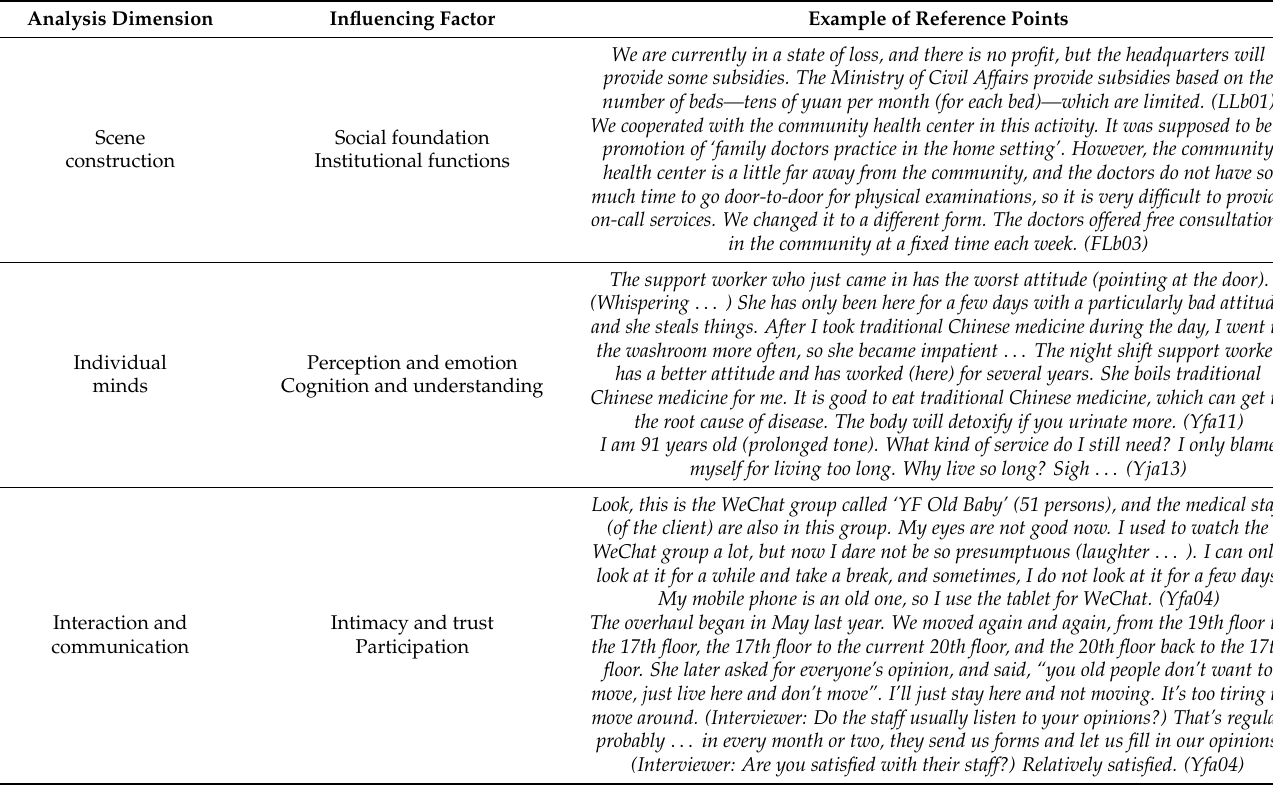
Table 4. Number of nodes in specific